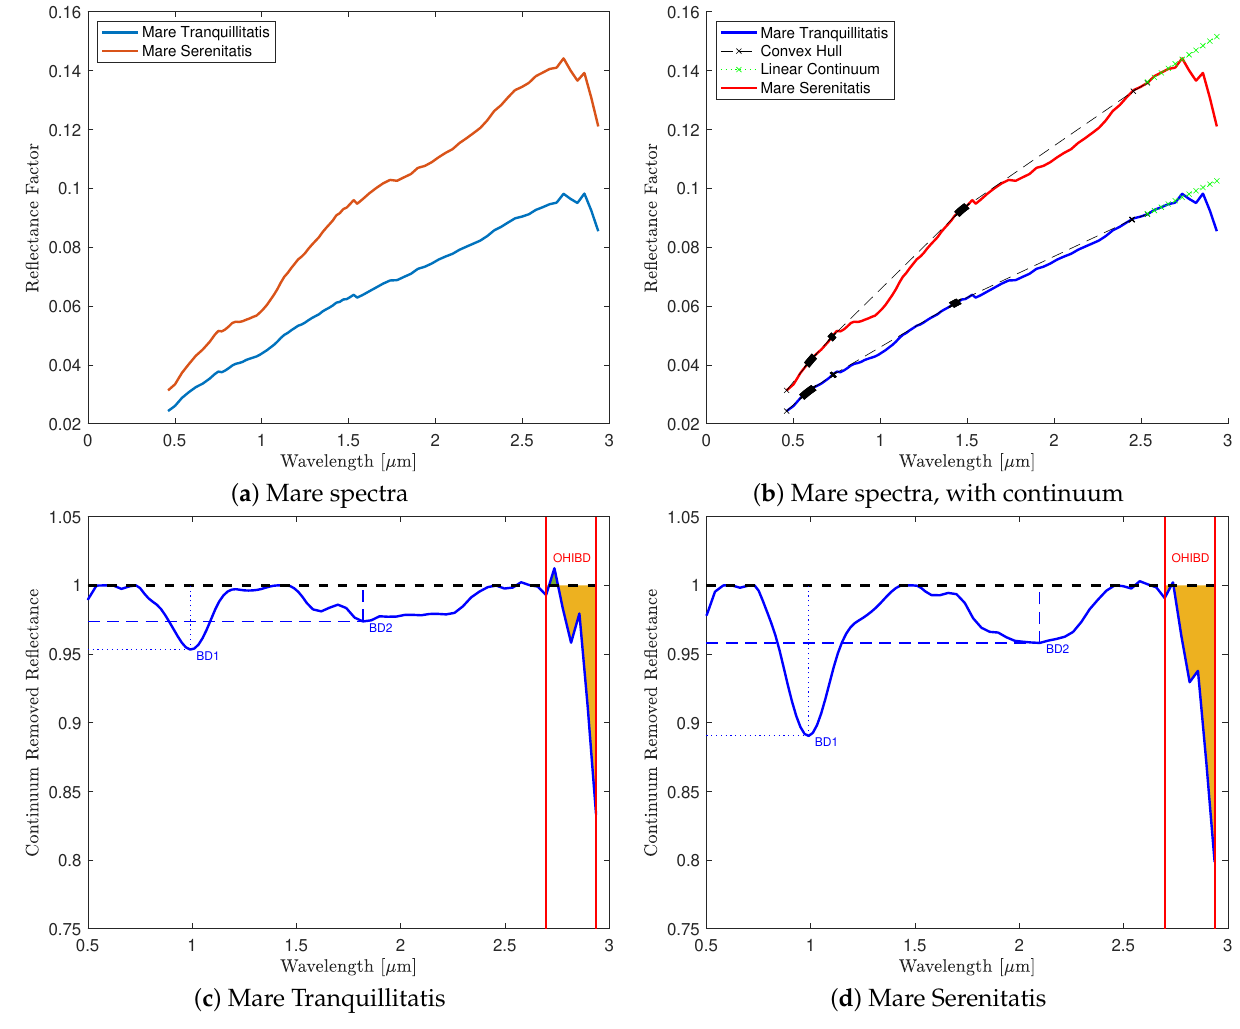
Figure 1. Example spectra of high-TiO 2 mare (blue curve) and low-TiO 2 mare areas (red curve), reflectance factor ( a ) and reflectance factor with continuum ( b ). The blue curve spectrum was taken from Mare Tranquillitatis as an average spectrum of a 4 ◦ × 4 ◦ area centered around (9 ◦ N, 34 ◦ E). The red curve spectrum was extracted from Mare Serenitatis as an average spectrum of a 4 ◦ × 4 ◦ area centered around (24 ◦ N, 18 ◦ E). The continuum-removed spectra are shown in ( c , d ) for Mare Tranquillitatis and Mare Serenitatis, respectively. For BD1 and BD2, the continuum is defined as the convex hull of the spectrum. For the 3 µ m range, the continuum is a linear function fitted to the values between 2.537 and 2.657 µ m marked in green in ( b